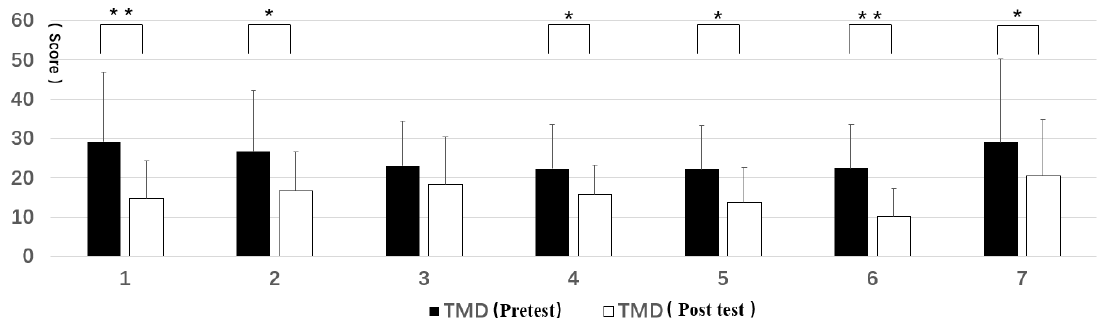
Figure 8. Pre- and post-test of total mood disturbance (TMD): ( 1 ) structure, ( 2 ) wood, ( 3 ) wood with bench, ( 4 ) wood with platform and bench, ( 5 ) platform with trees, ( 6 ) waterfall with trees, and ( 7 ) pool with plants. Interpretation: * means p < 0.05, ** means p < 0.01.